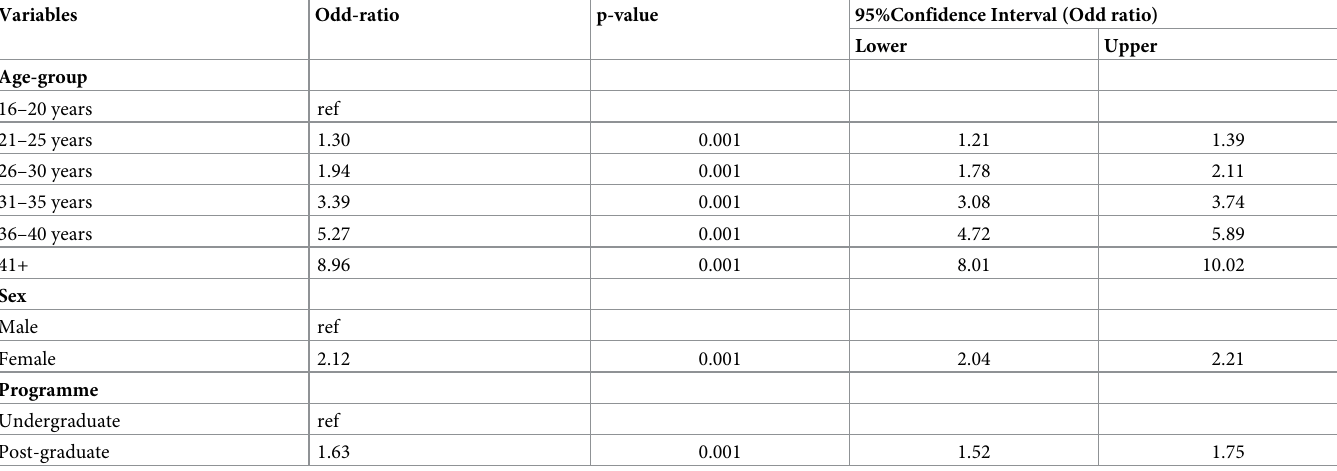
Table 5. Multivariate analysis showing the association between socio-demographic characteristics of students with overweight and obesity.